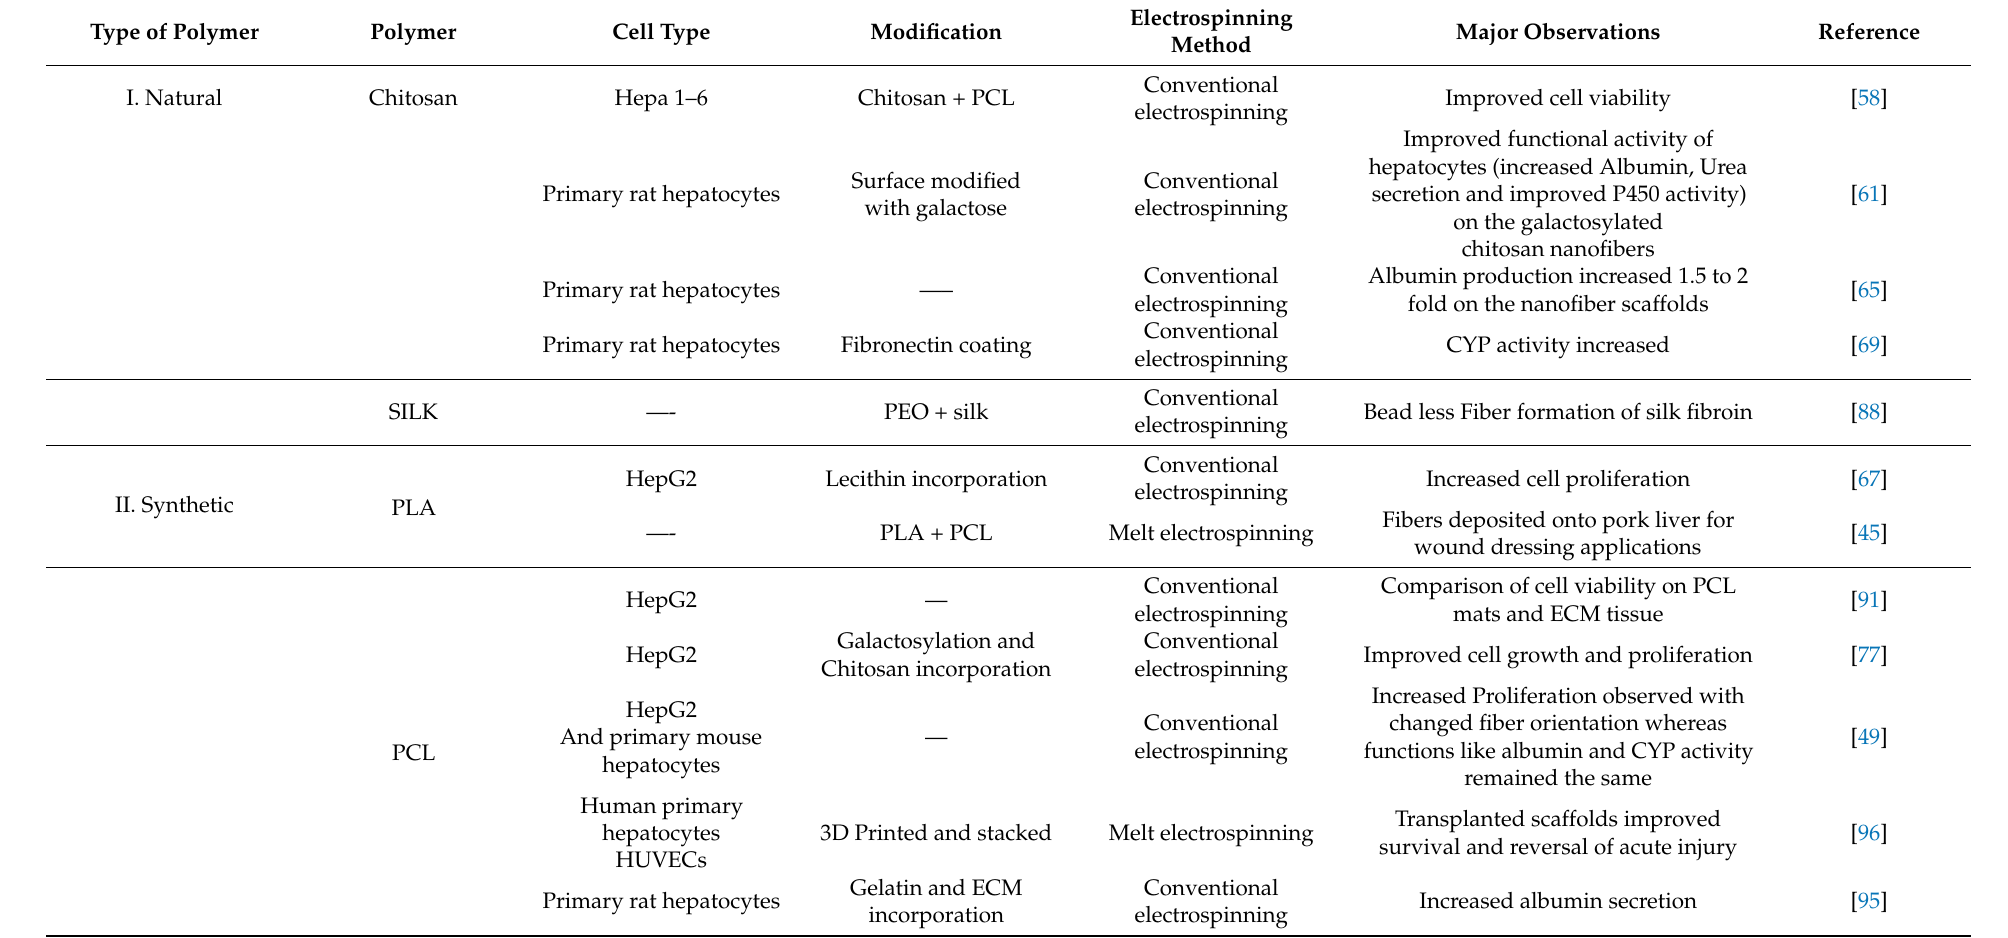
Table 1. Summary of the different polymers and their electrospinning strategies used in liver tissue engineering to